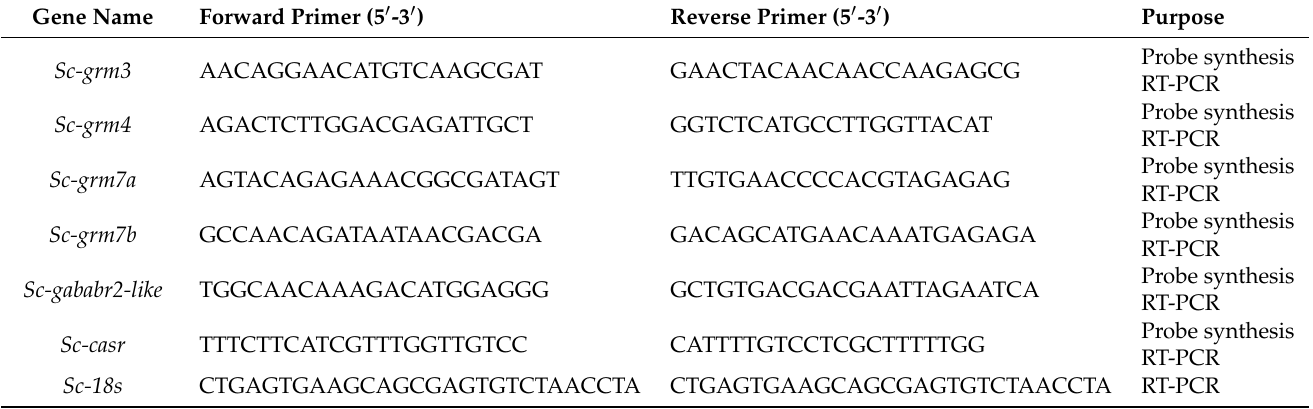
Table 1. Primer sequences used in the